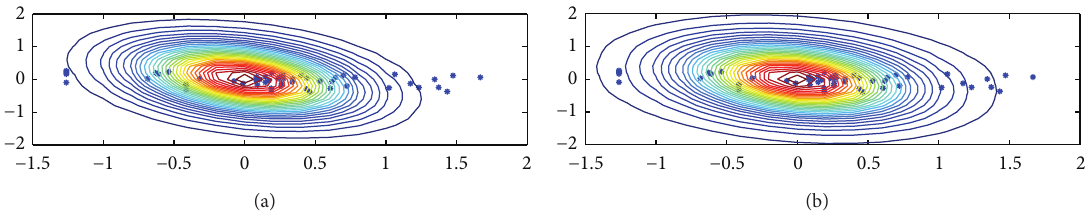
Figure 2: Plot of contours of posterior predictive density of pair (𝑦 1 ,𝑦 2 ) under parametric model and semiparametric model 𝑀 𝜖 : (a) corresponds to parametric model and (b) corresponds to semiparametric model with 𝐺 = 50 .